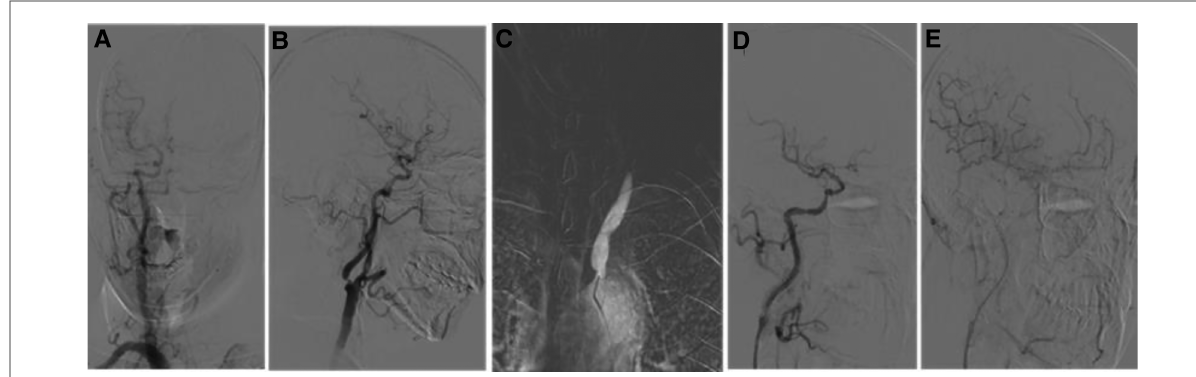
FIGURE 2 Digital subtraction angiography (DSA) image after admission. ( A ) DSA from the right common carotid artery showing that the anterior communication is open and compensated from right to left. ( B ) Severe stenosis of the C1 segment of the right internal carotid artery. ( C ) DSA of the left common carotid artery showing an occlusion of the common carotid artery. ( D,E ) Postoperative angiographyof the right CAS showing an improvement of right to left blood fl ow compensation. CAS, carotid artery stent implantation.